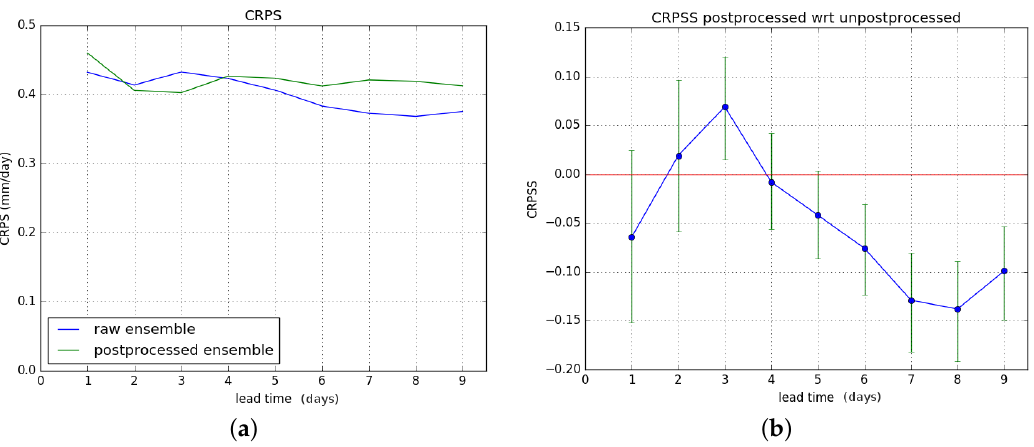
Figure 11. Continuous Ranked Probability Score (CRPS) and Continuous Ranked Probability Skill Score (CRPSS) improvement for hydrological winter. ( a ) CRPS comparison; ( b ) Improvement due to postprocessing.